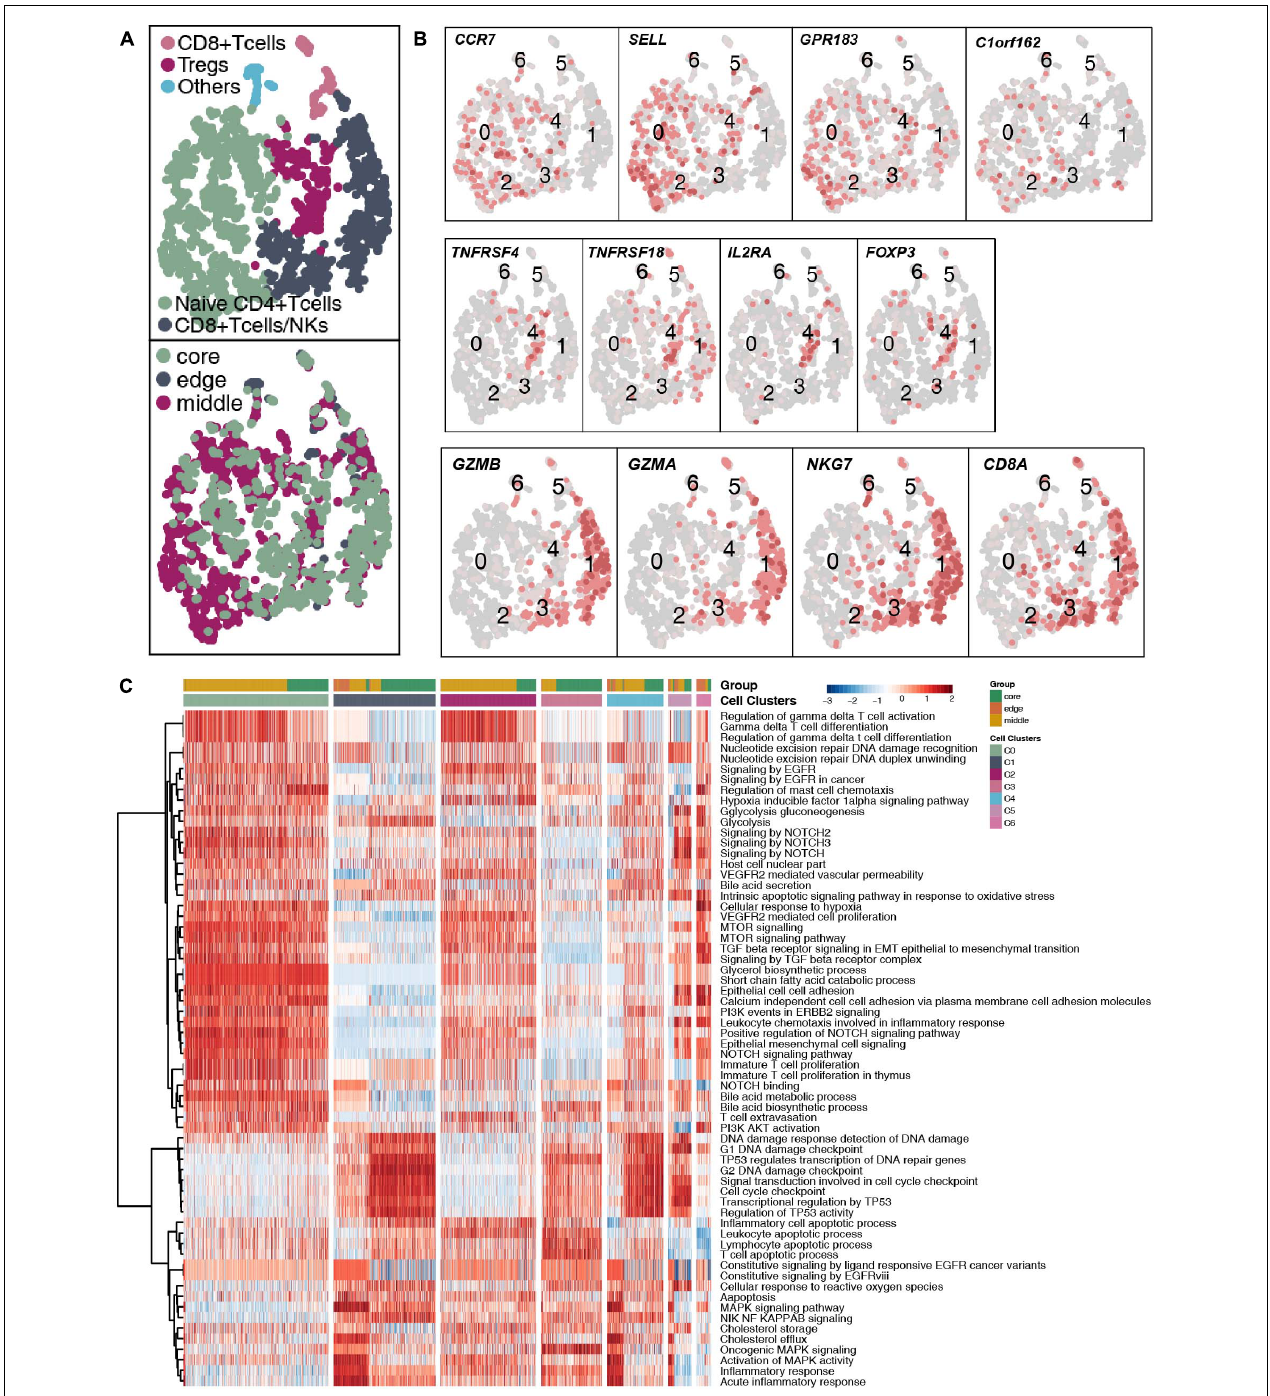
FIGURE 2 | T cell clusters in LUAD. (A) tSNE plot of 1,928 T cells, which are color-coded by their associated cluster or the sample location. (B) tSNE plot, which is color-coded for expression of marker genes for the cell types, as indicated. (C) Differences in pathway activities scored per cell by ssGSEA between the different T cell